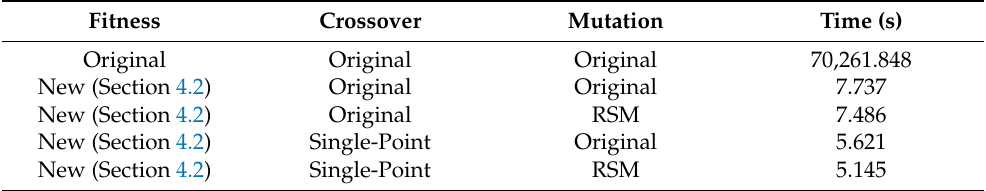
Table 4. Computational time results using a Raspberry Pi